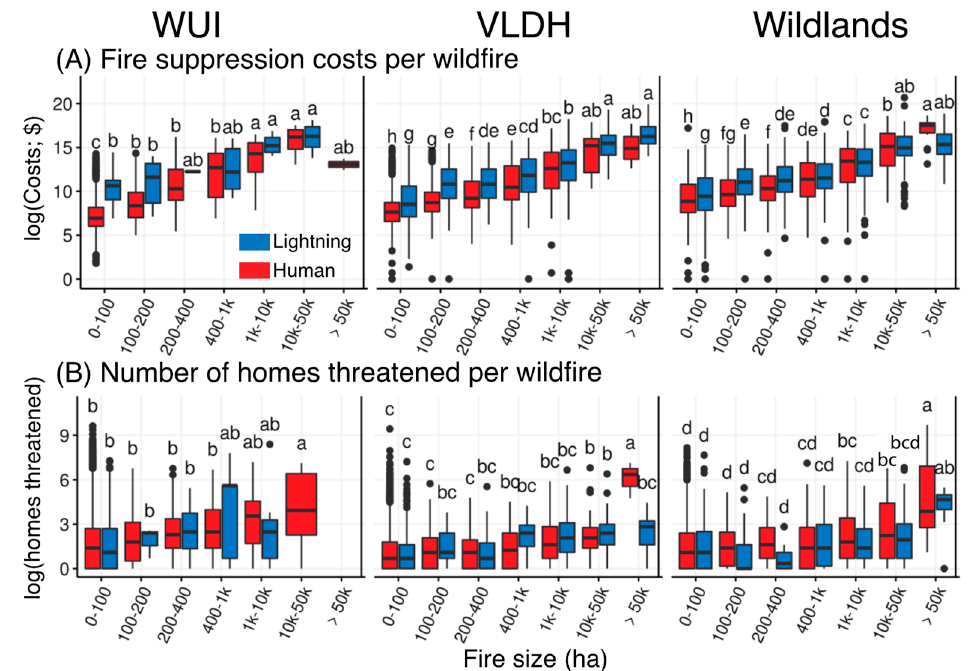
Figure 6. The log mean number of ( A ) fire suppression costs and ( B ) homes threatened per human- and lightning-started wildfire event initiated within the wildland-urban interface (WUI), Very low-density housing (VLDH), and wildlands, stratified by fire size in hectares between 1992 and 2015. Error bars indicate the 95th confidence interval around the mean of each group. Tukey’s HSD pairwise comparison of the means is represented by di ff ering letters and letter combinations indicating significant di ff erences among groups ( p < 0.0001).